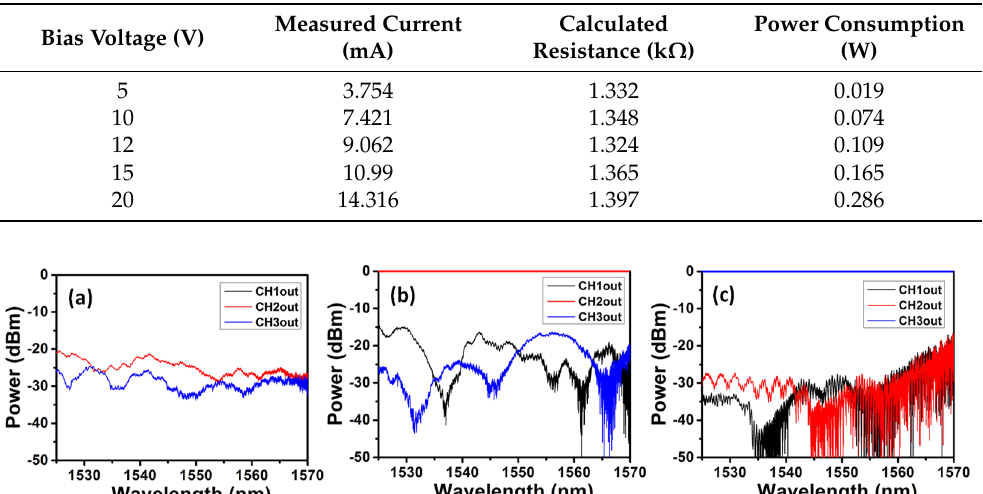
Table 1. Performance of a single 2 × 2 switch.